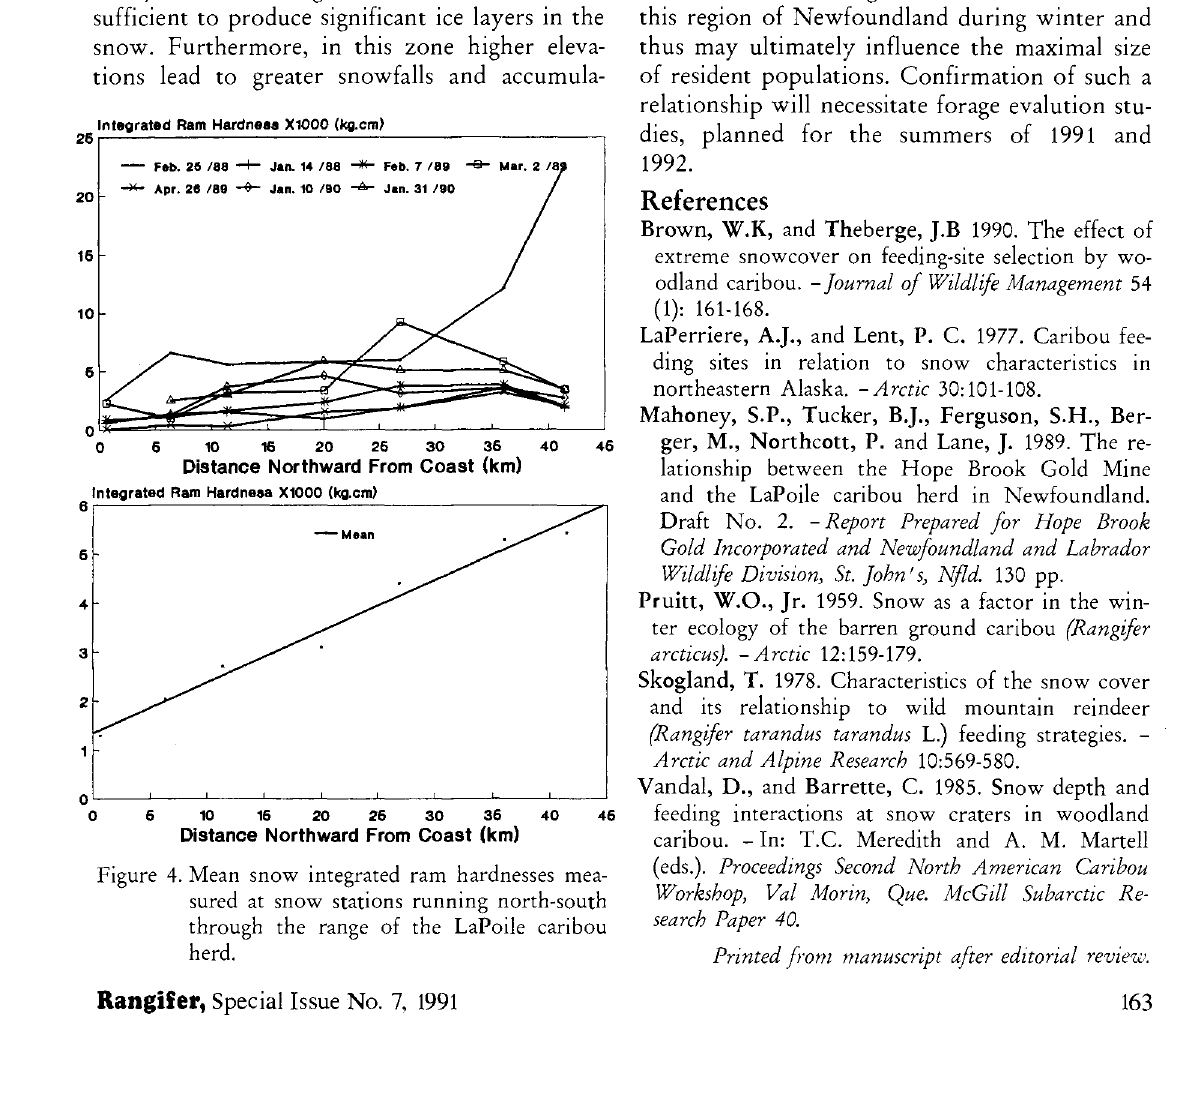
Figure 4. Mean snow integrated ram hardnesses mea sured at snow stations running north-south through the range of the LaPoile caribou